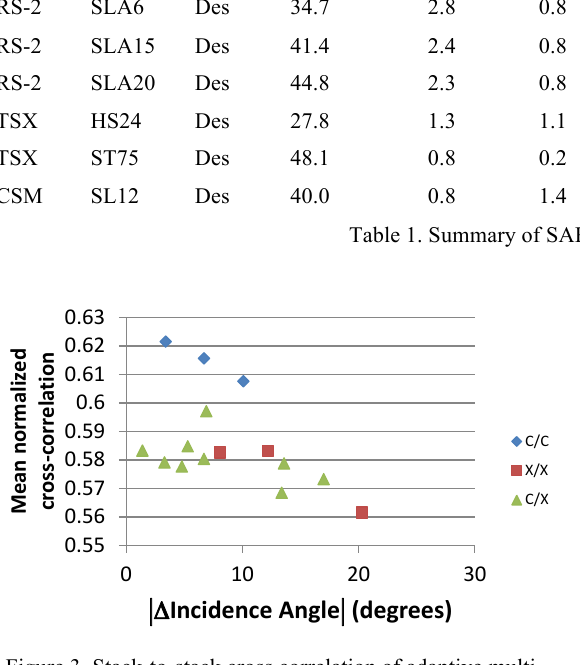
Figure 3. Stack-to-stack cross correlation of adaptive multi- looking neighbourhoods vs incidence difference.